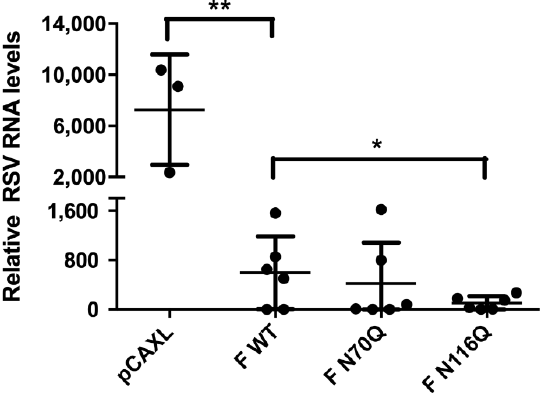
Figure 8. Lung viral RNA levels after RSV challenge. Five days post infection of the immunized mice with 1 × 10 6 PFU of RSV A2-K-line19F, the left lungs were collected and homogenized. To determine relative RNA levels in the infected lungs RT-qPCR was performed. * p < 0.05, ** p < 0.01; n = 3–6 animals/group (Student’s unpaired one-tailed t test).